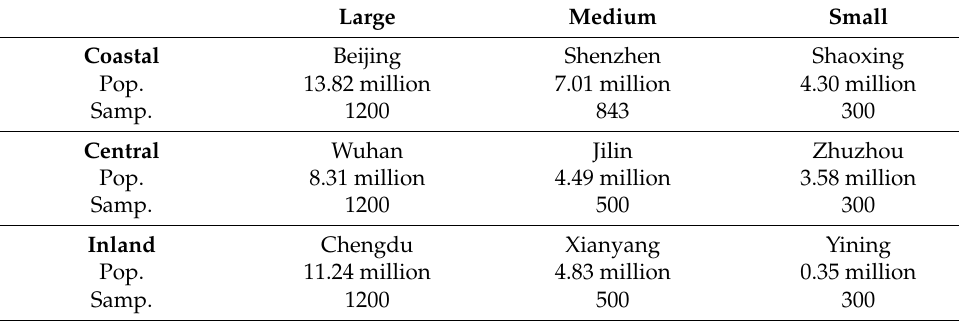
Table A1. Population and Sample Size of Each Sampling Point.